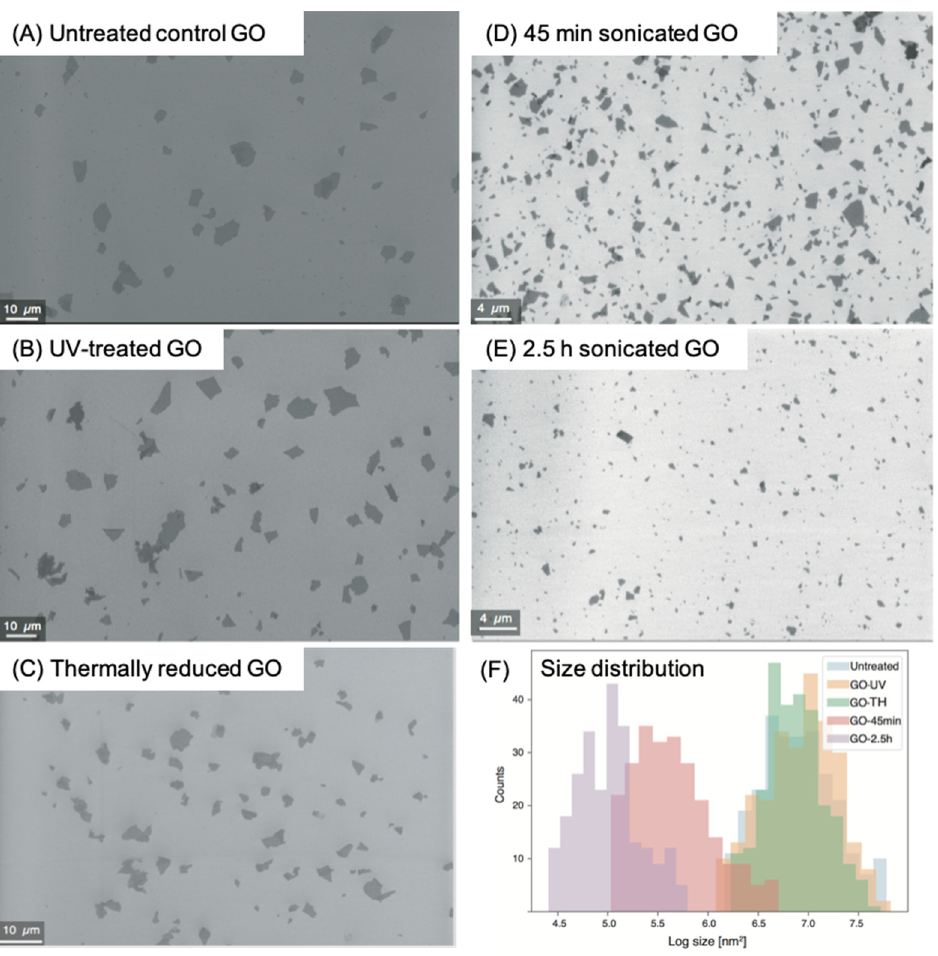
Figure 1. Graphene oxide (GO) morphology measured using a scanning electron microscope (SEM): ( A ) untreated control GO, Scale bar: 10 µ m; ( B ) GO treated with 96 h UV, Scale bar: 10 µ m; ( C ) GO treated with 96 h thermal reduction, Scale bar: 10 µ m; ( D ) GO treated with 45 min bath sonication, Scale bar: 4 µ m; ( E ) GO treated with 2.5 h bath sonication, Scale bar: 4 µ m; and ( F ) size distribution of the 5 GO groups. The size distribution was obtained by image analysis software where >300 GO flakes were analyzed for each condition. x -axis in F: GO flake counts, y -axis: base-10 logarithmic calculation of size (nm 2